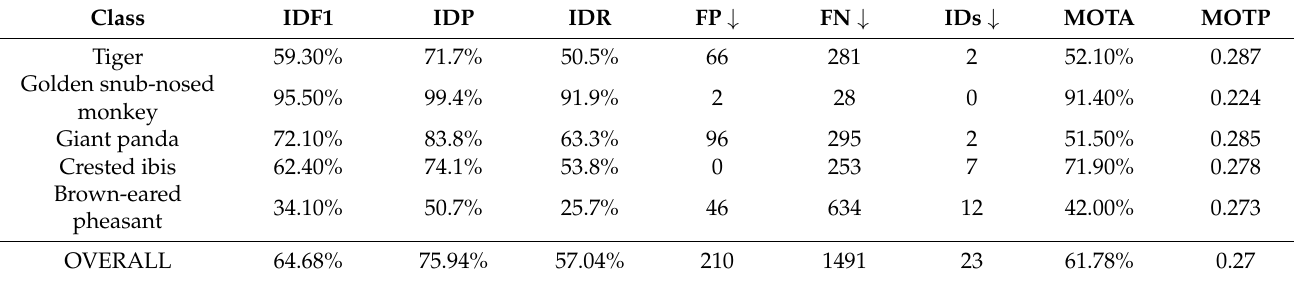
Table 2. Results of the proposed MOT framework for MOT-EA.